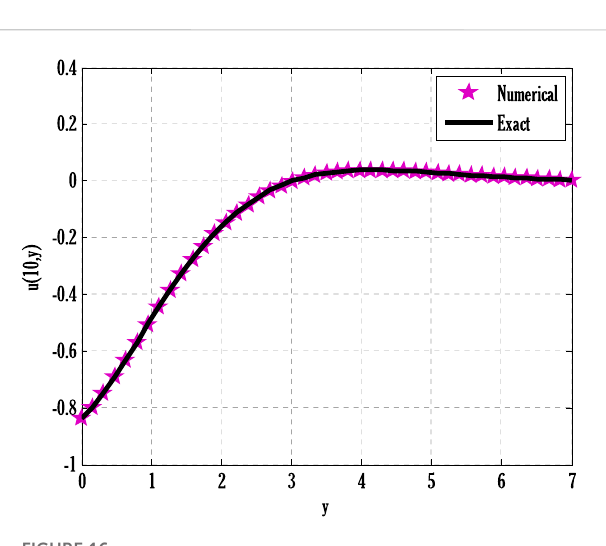
FIGURE 14 Contour plot of temperature pro fi le using N t (cid:2) 270 , N y (cid:2) 45 , L (cid:2) 27 , t f (cid:2) 1 , E c (cid:2) 01 . 9 , λ 1 (cid:2) 0 . 1 , λ 2 (cid:2) 0 . 1 , R d (cid:2) 0 . 1 , P r (cid:2) 1 , S c (cid:2) 1 , R d (cid:2) 0 . 1 , M (cid:2) 0 . 1 , β (cid:2) 2 , F r (cid:2) 0 . 1 , μ 1 (cid:2) 0 . 05 , λ (cid:2) 0 . 1 , μ 2 (cid:2) 0 . 1 , γ (cid:2) 0 . 9 , N b (cid:2) 0 . 15 , N t (cid:2) 0 . 1 , u ( t , 0 ) (cid:2) sin ( 3 t ) .